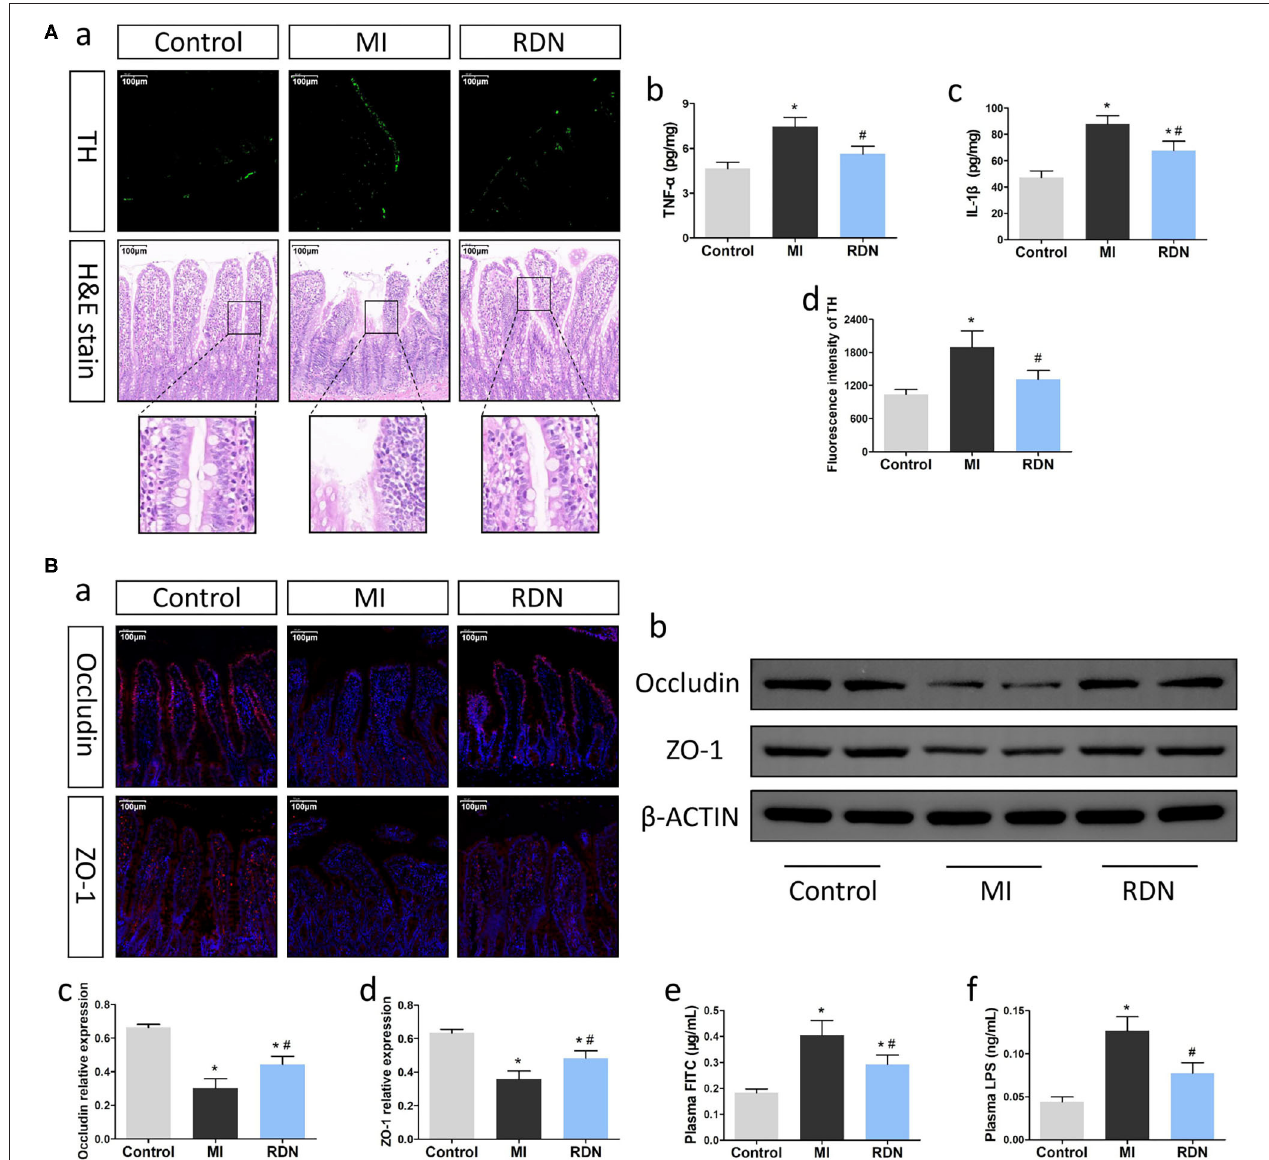
FIGURE 2 | RDN effectively improves the intestinal injury in MI rats. (A) RDN reduces the intestinal sympathetic nerve activity and decreases the levels of intestinal pro-inflammatory cytokines to preserve the intestinal barrier integrity in MI rats. (a) Representative images of anti-TH immunofluorescent staining (magnification, 200 × ) and HE staining (magnification, 200 × ) in the intestinal tissues of rats. (b,c) ELISA analysis of intestinal TNF- α and IL-1 β levels. (d) Quantitative analysis of anti-TH fluorescent signals in the intestine. (B) RDN mitigates the MI-increased intestinal permeability in rats. (a) Representative immunofluorescent images of anti-Occludin and anti-ZO-1 staining in the intestine of each group of rats (magnification, 200 × ). (b) Western blotting analysis of the relative levels of Occludin, ZO-1, and the control β -actin expression in intestinal tissues of rats. (c,d) Quantitative analysis of Occludin and ZO-1 expression. (e) The plasma FITC-dextran concentrations in rats. (f) The levels of plasma LPS in rats. Data are representative images or expressed as the mean ± SEM of each group of rats from three separate experiments. * P < 0.05 vs. the Control group; # P < 0.05 vs. the MI group.